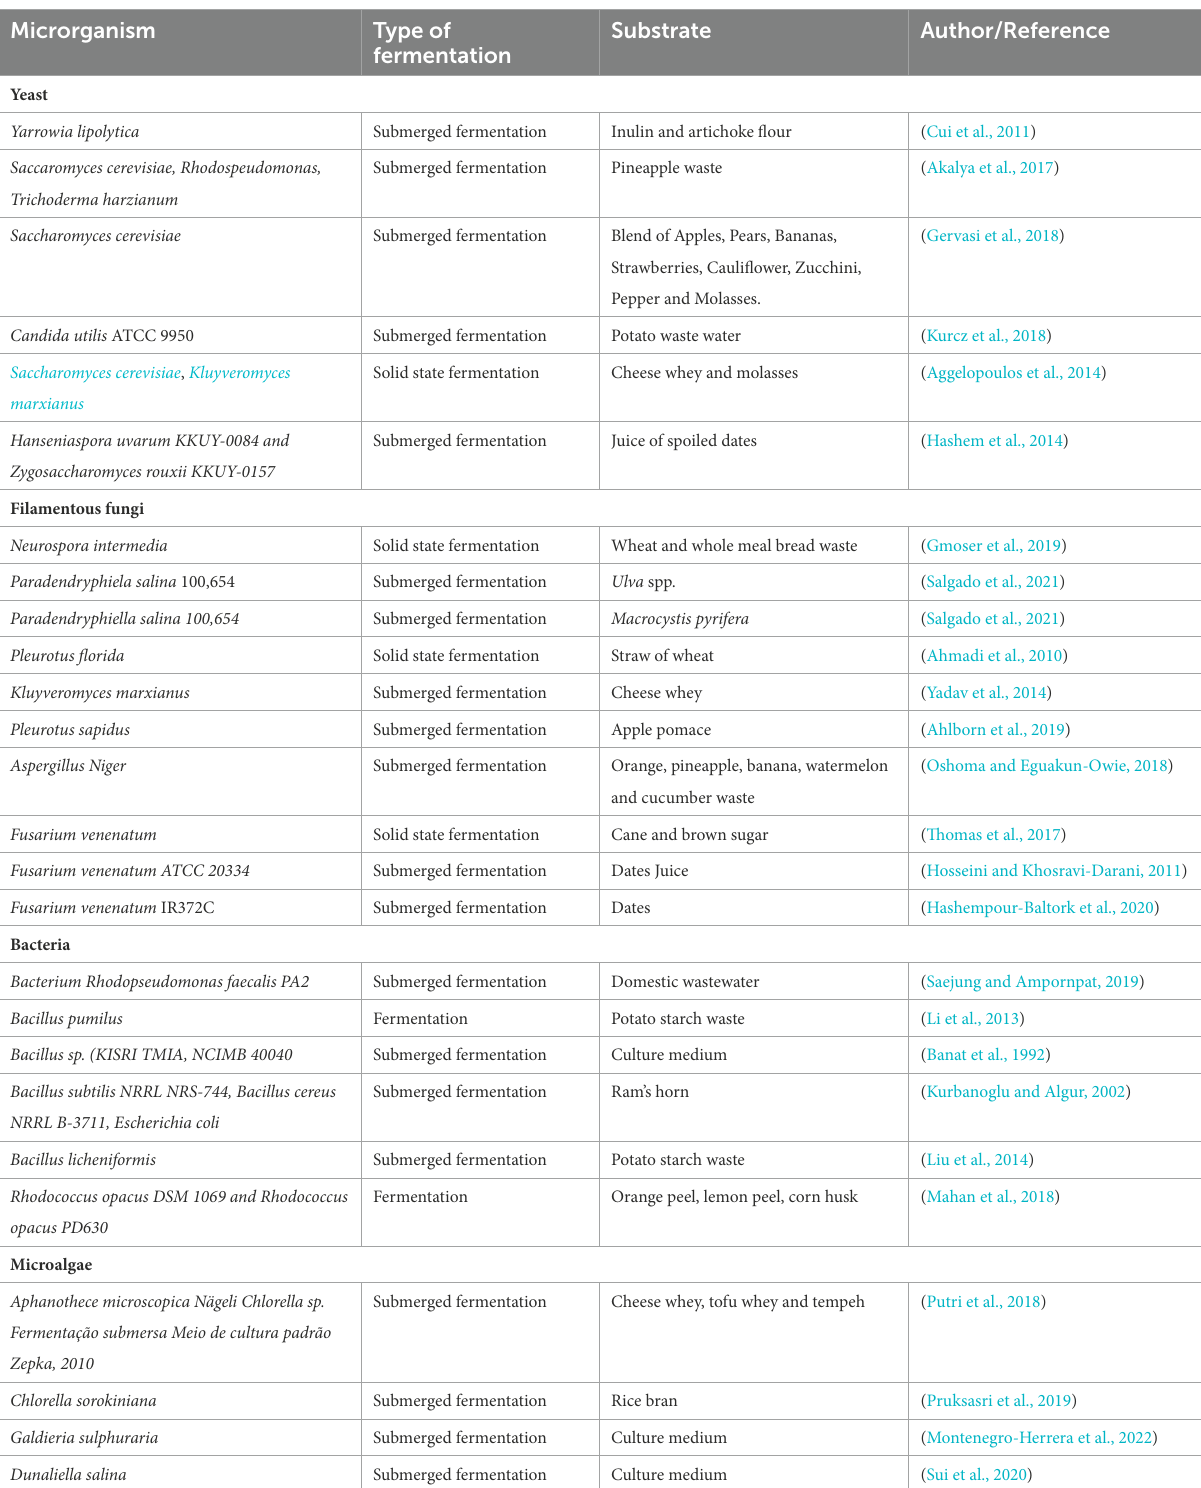
TABLE 4 Microorganisms used in the production of SCP, type of fermentation, and